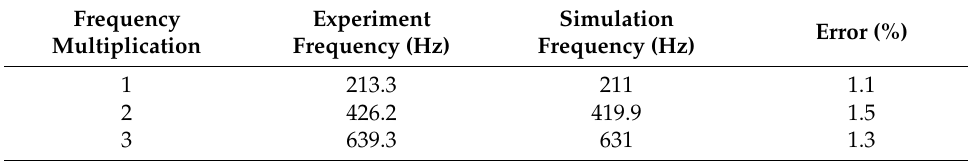
Table 6. Frequency comparison analysis.